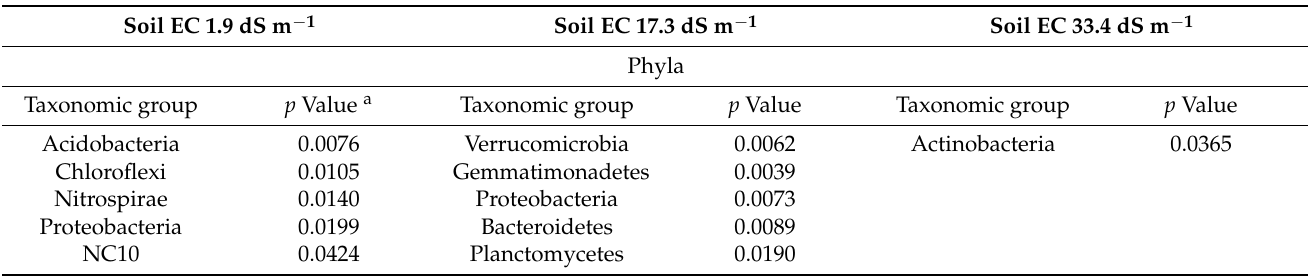
Table 4. The effect of treatment (unamended soil or soil amended with NDF or soil amended with young maize plants) on the soil bacterial community structure at the phyla and genus taxonomic level in soil with EC 1.9 dS m − 1 (low), EC 17.3 dS m − 1 (medium), and EC 33.4 dS m − 1 (high) using a compositional approach, i.e., the analysis of differential abundance taking sample variation into account with the ALDEx2 package